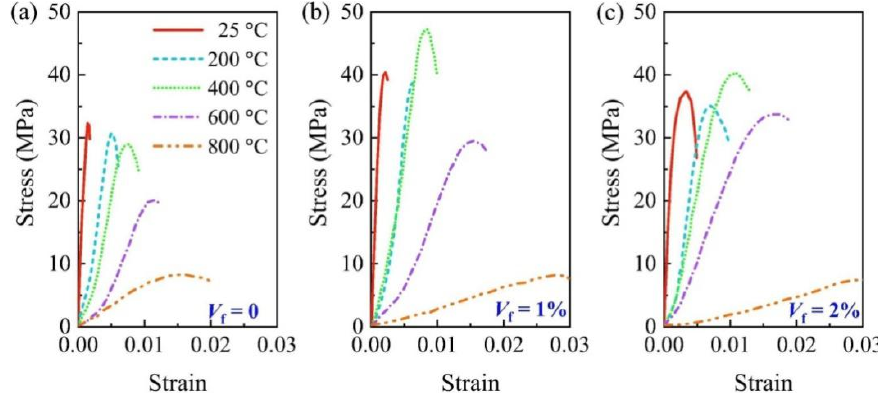
Figure 9. Stress–strain curves of SFRC exposed to di ff erent temperatures with steel fiber dosage of 0% Figure 9. Stress – strain curves of SFRC exposed to different temperatures with steel fiber dosage of 0% ( a ), 1% ( b ) and 2% ( c ) (a), 1% (b) and 2% (c) [44].